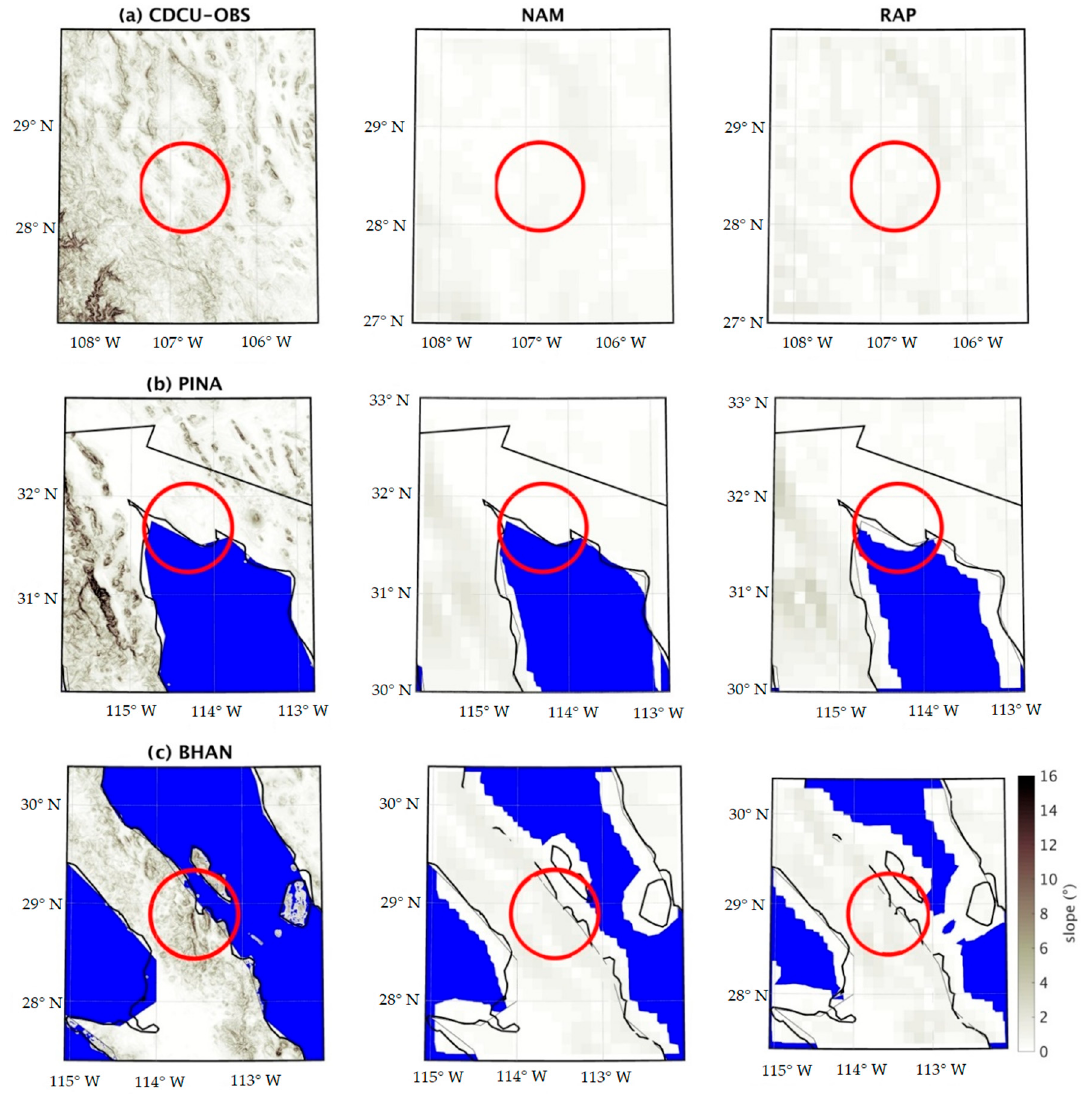
Figure 9. GTOPO30 [32] slope and represented slope terrain by NAM and RAP around weather stations. The red circles are 50 km in radius centered at ( a ) CDCU, ( b ) PINA and ( c ) BHAN weather station.